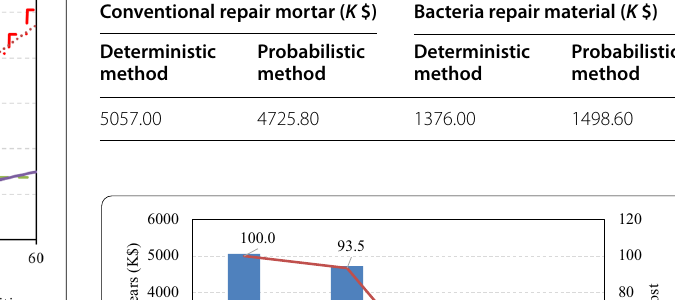
Fig. 9 Variation of total repair cost with varying exposure conditions and repair method (deterministic and probabilistic method).